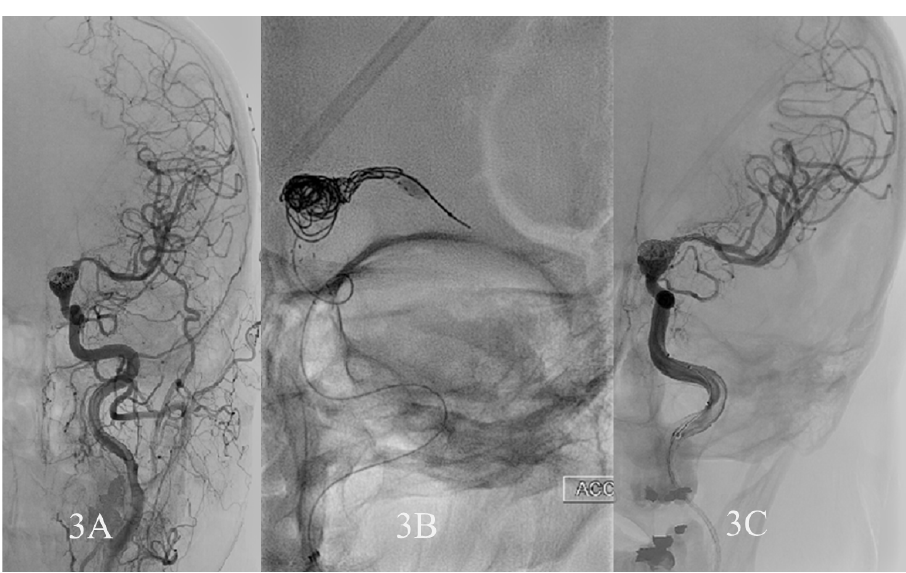
Fig. 3A. Angiogram of the left ICA after stent-assisted coiling. The most prominent part of the aneurysm was partially coiled. B. Balloon angioplasty of the distal part of the flow diverter stent immediately after its implantation. There were dislodged coils, which were placed into the aneurysm 3 weeks ago. C. Final angiogram which proved a brisk flow into the MCA. The A1 had already been occluded during acute ischemic stroke. There was no cross filling via the anterior communicating artery. The left anterior cerebral artery had retrograde flow through the pial collaterals from the left posterior cerebral artery (not shown).